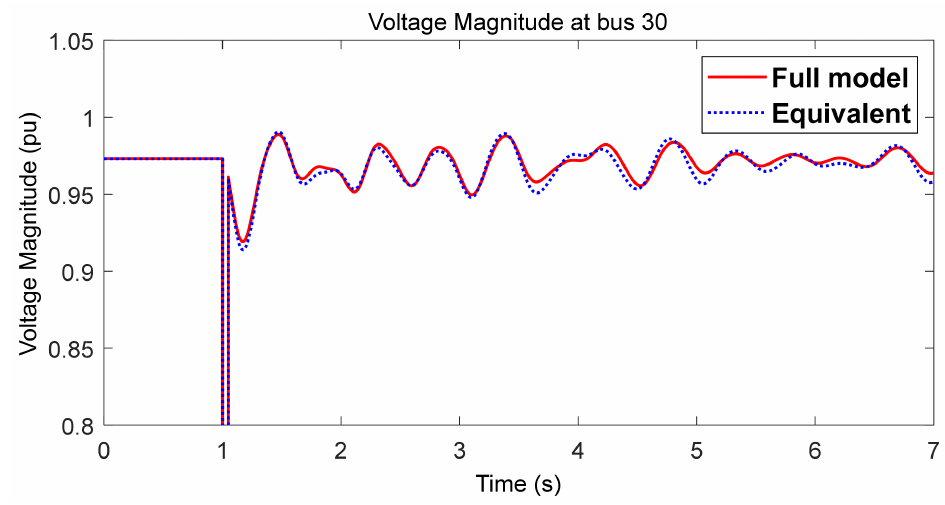
Figure 7. Bus 30 voltage magnitude comparison with bus-to-ground fault at bus 30.